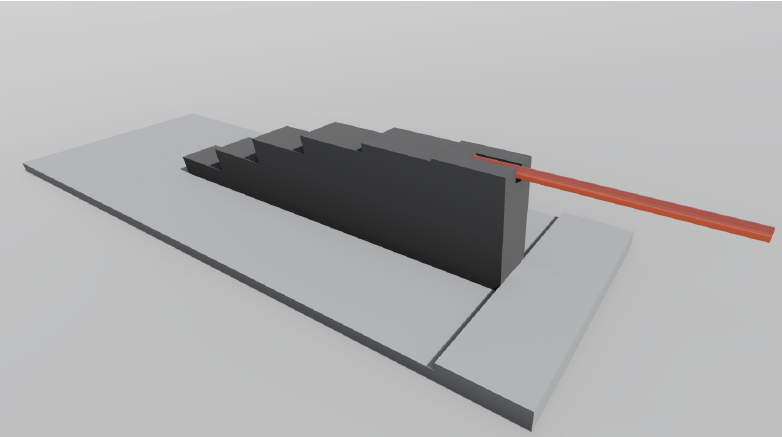
Figure 11. Practical shorting of the pin on the ridge. The coaxial pin (in orange) is inserted in a groove realized in the first ridge (gray), and pasted via a conductive